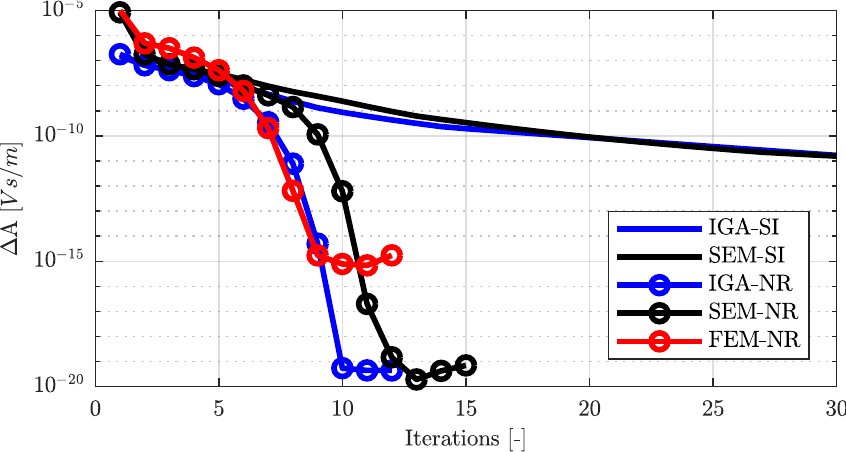
Figure 2. Comparison of the convergence of the residual in Benchmark